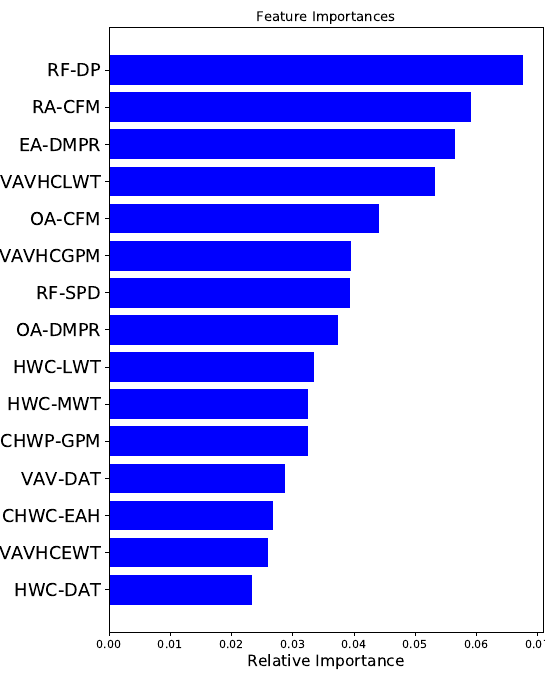
Figure 3. Selected feature